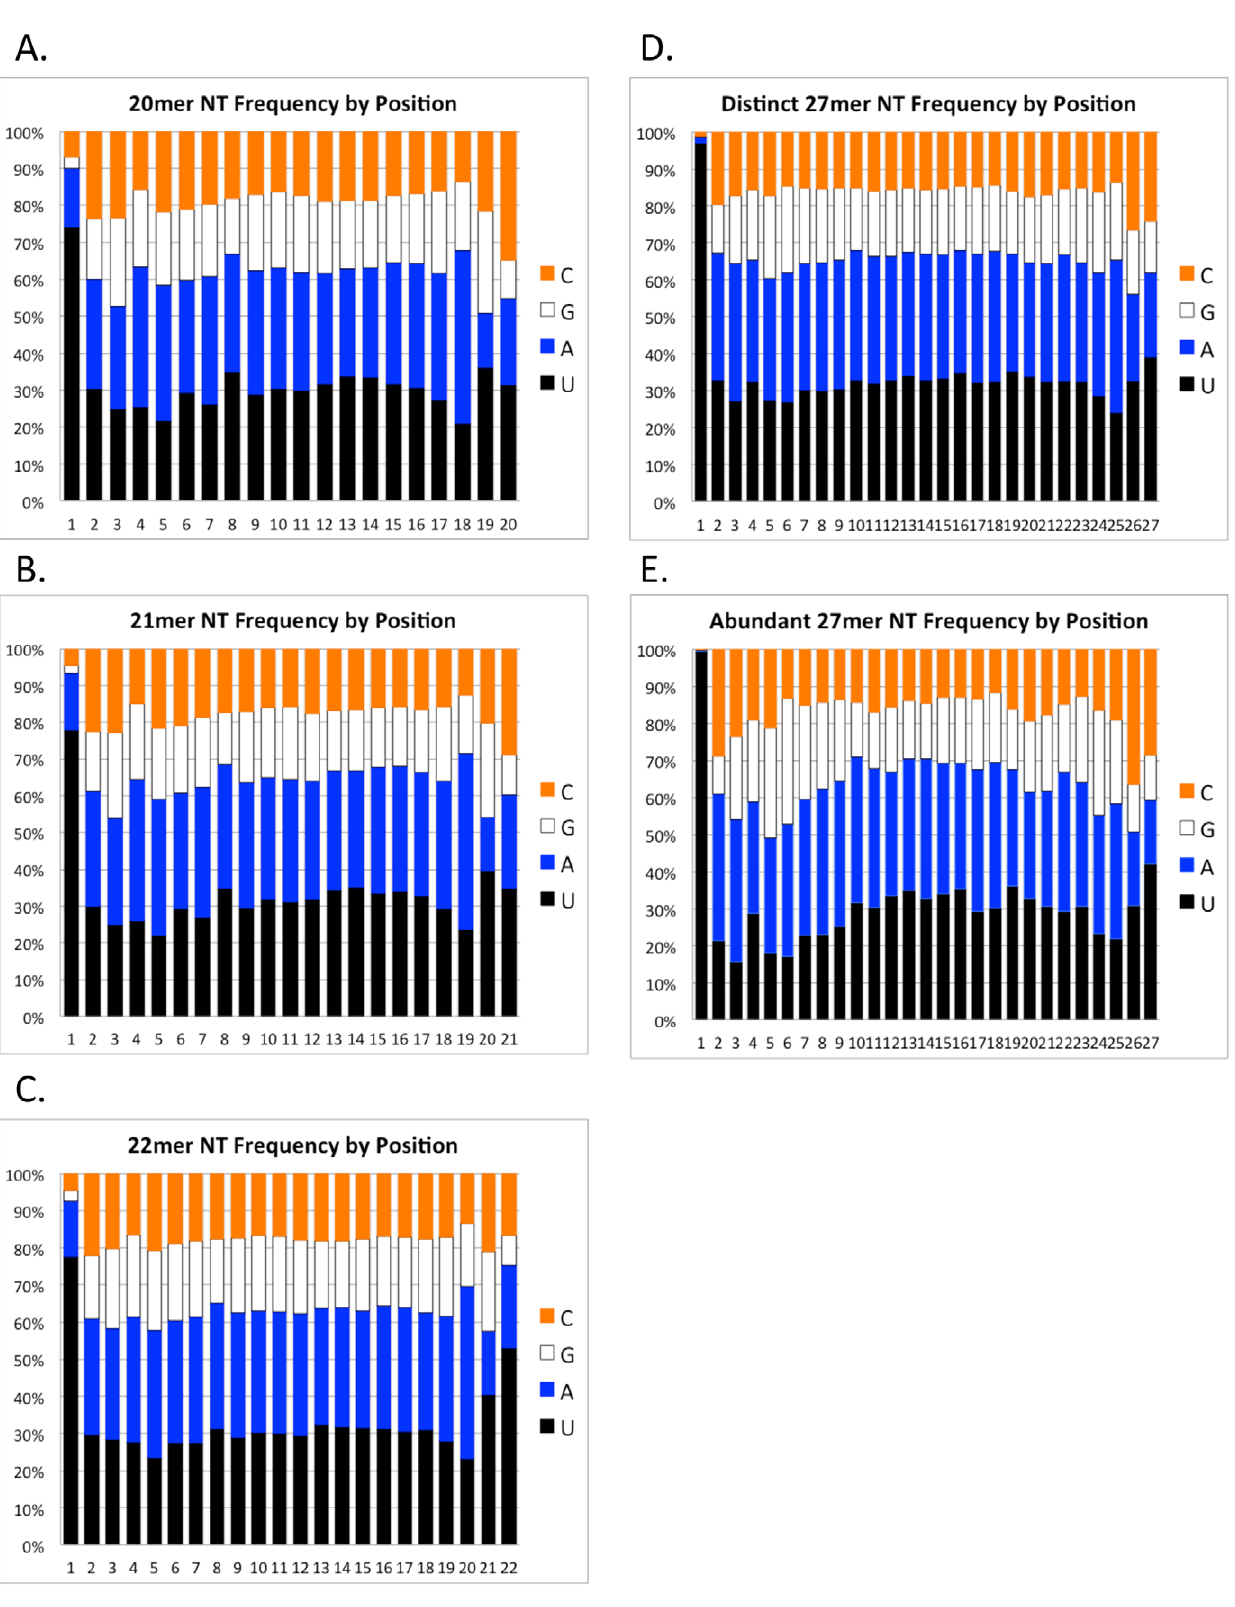
Figure 5. Nucleotide position bias in the different classes of sequenced small RNAs. These charts show the nucleotide frequency at each position for different small RNA size classes. The distinct sequences in the veg09_03 library and the mat24_05 library were filtered against non-coding RNAs. The distinct RNAs that made it through the filter were selected by size and the nucleotide composition of each position for the indicated size class was determined. A . Distinct 20 mers from the veg09_03 library (222,272 sequences). B . Distinct 21 mers from the veg09_03 library (416,2227